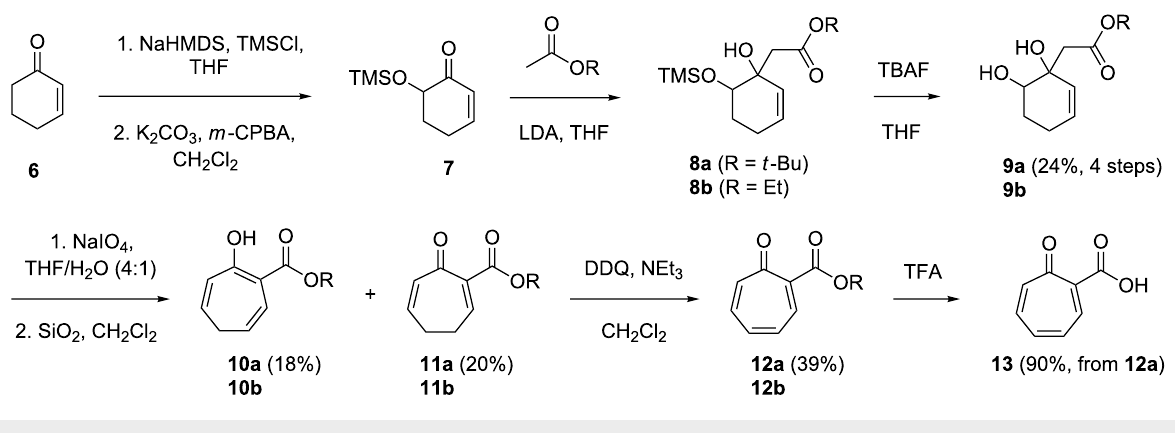
Scheme 1: Synthesis of tropone-2-carboxylic acid ( 13 ).